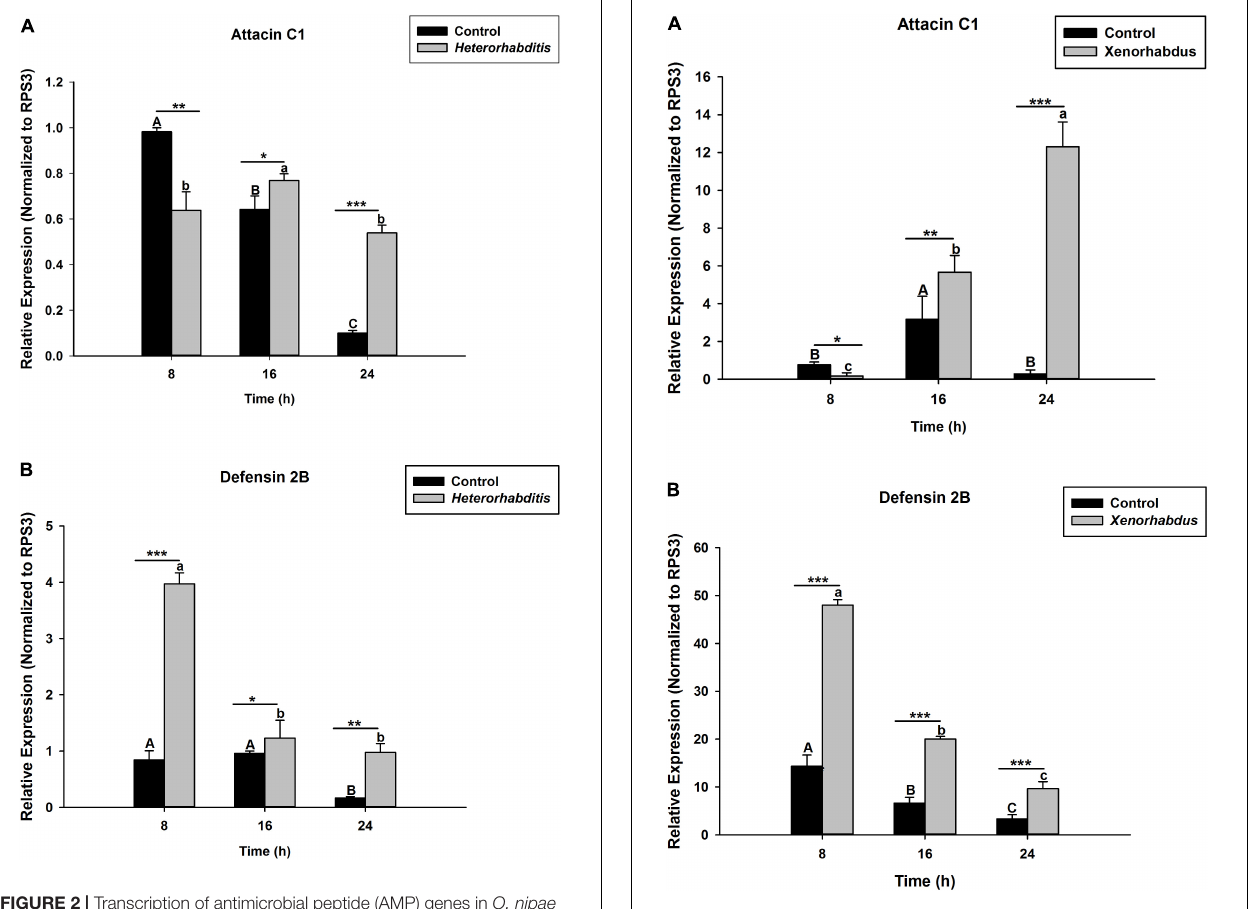
the OnRelish /NF- κ -B p110 subunit-like proteins were